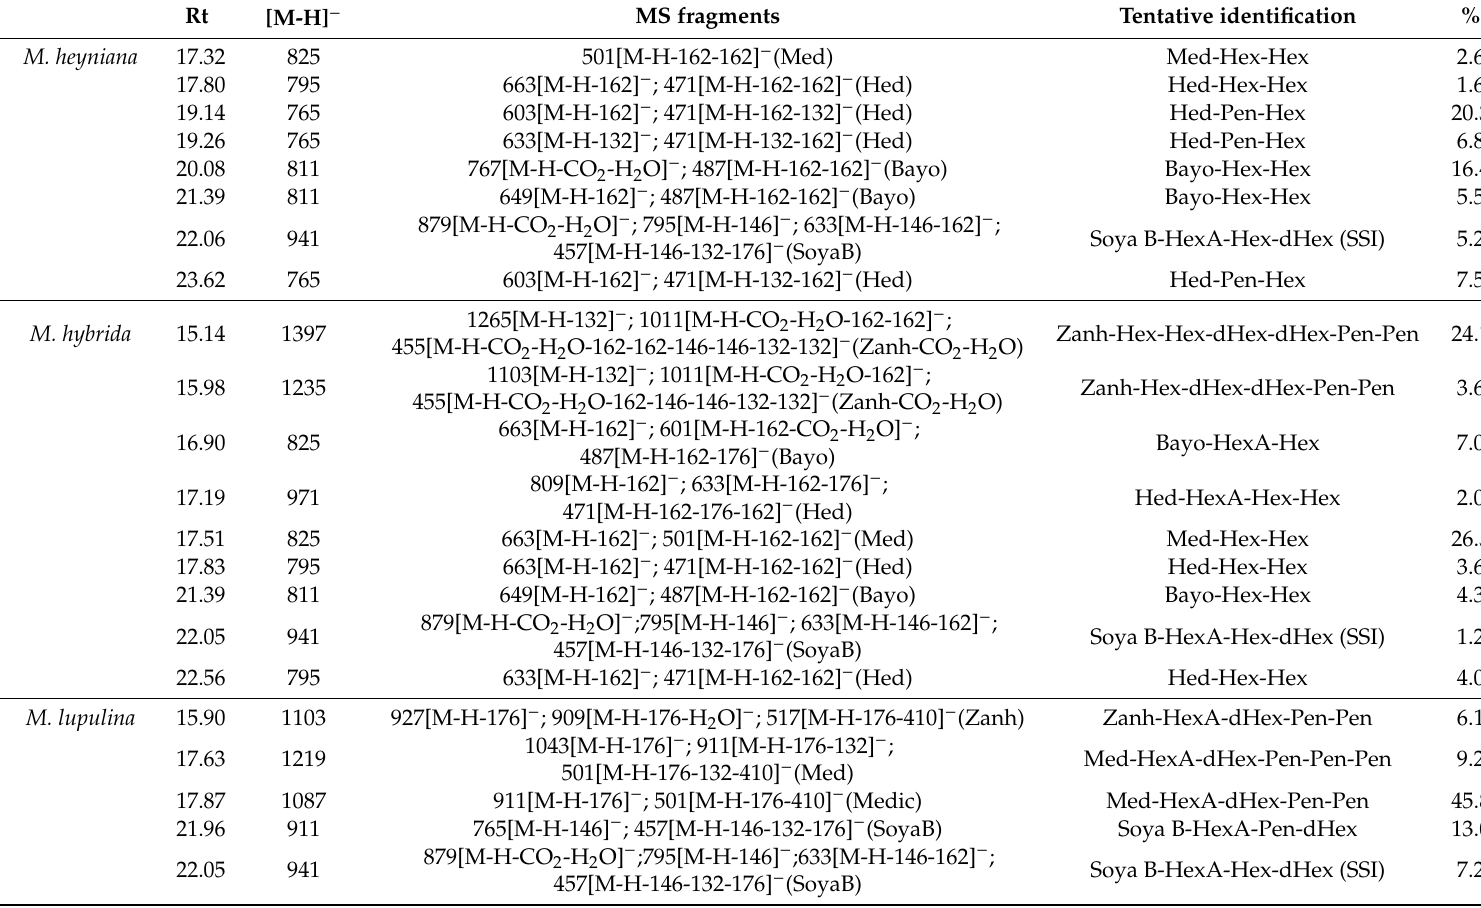
Table 3. The most abundant tentatively identified saponins in the five Medicago spp. and their quantitative evaluation (% of total saponins). Rt [M-H] − MS fragments Tentative identification